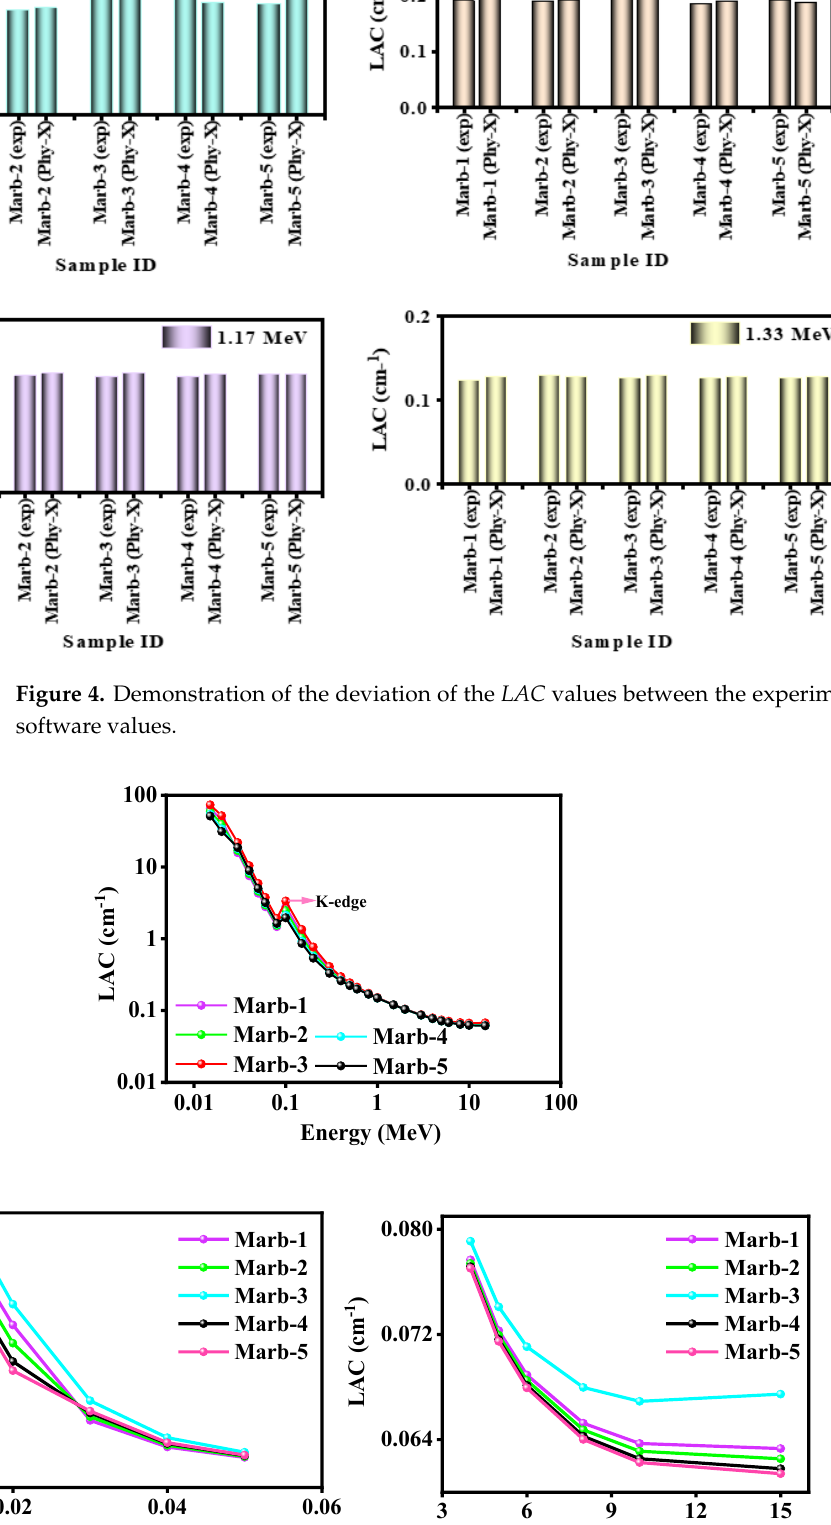
To understand the shielding ability of any absorber, HVL is one of the most valid parameters. The value of HVL was measured for the prepared composites (polyes- ter/waste marble/PbCO 3 /CdO) using the Phy-X software in the energy range from 0.015 MeV to 15 MeV. It is well established that the K-edge of lead is 88 keV, whereas Figure 5 shows that the value of the k-edge of the studied lead sample was ~100 KeV. It indicates that the studied sample showed better shielding ability at energy100 KeV. Figure 6 provides the HVL of the prepared composites (polyester/waste mar- ble/PbCO 3 /CdO) against incident photon energy. The results revealed that from energies of 0.015 – 0.6 MeV and 3 – 15 MeV, Marb-3 gave the lowest value of HVL, whereas from 0.8 – 3 MeV negligible variation was found. Therefore, it can be stated that the prepared com- posite Marb-3 had the best shielding ability of the prepared samples.